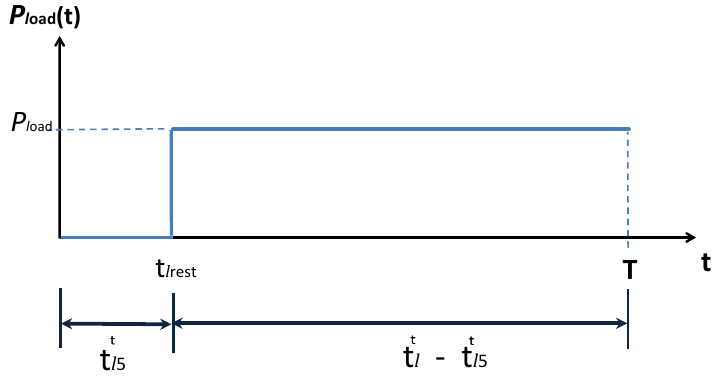
Figure 4. Step function of the load